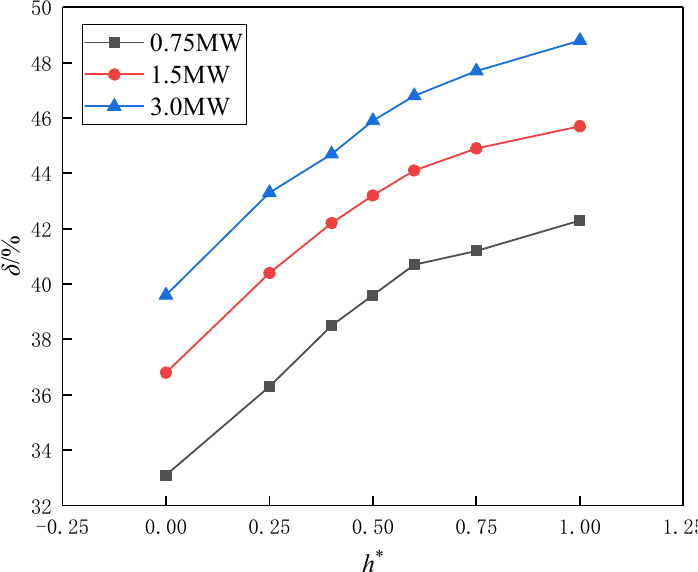
Figure 6. Relationship between the dimensionless descending height of the fire shutter and the smoke extraction